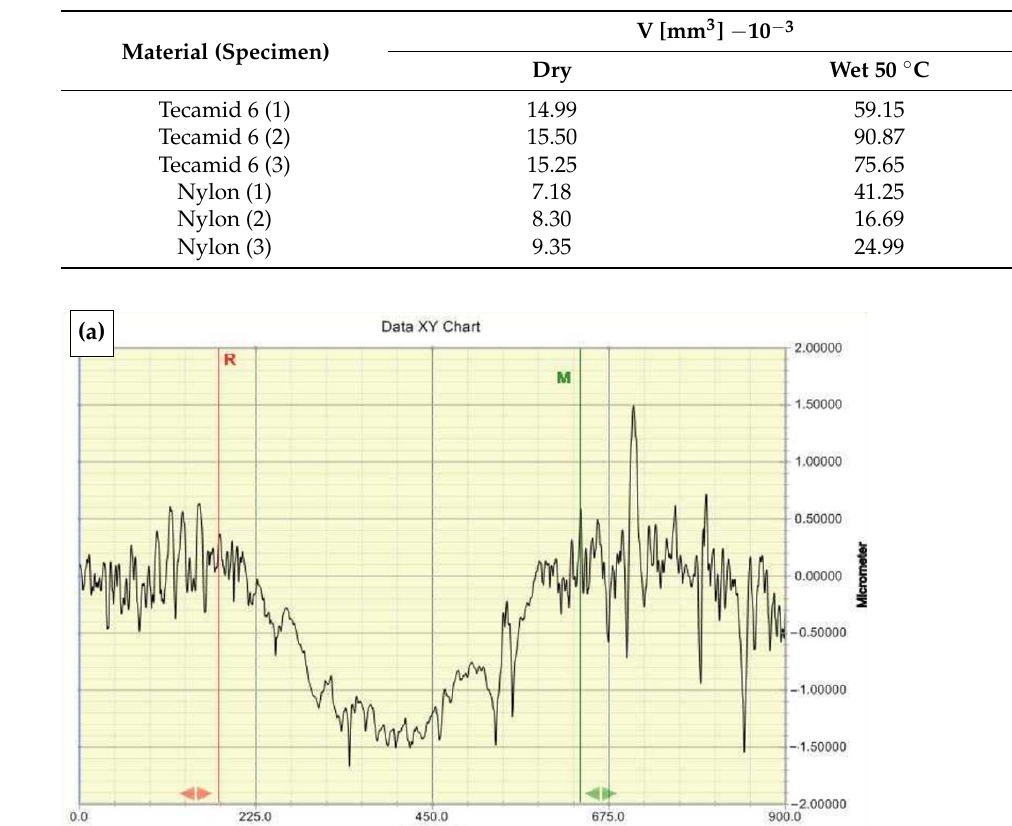
Figure 9. Comparison of friction coefficient results depending on the number of friction cycles and materials tested: ( a ) dry test; ( b ) wet test 50. Table 5. Volumetric wear on the surface of the specimens.